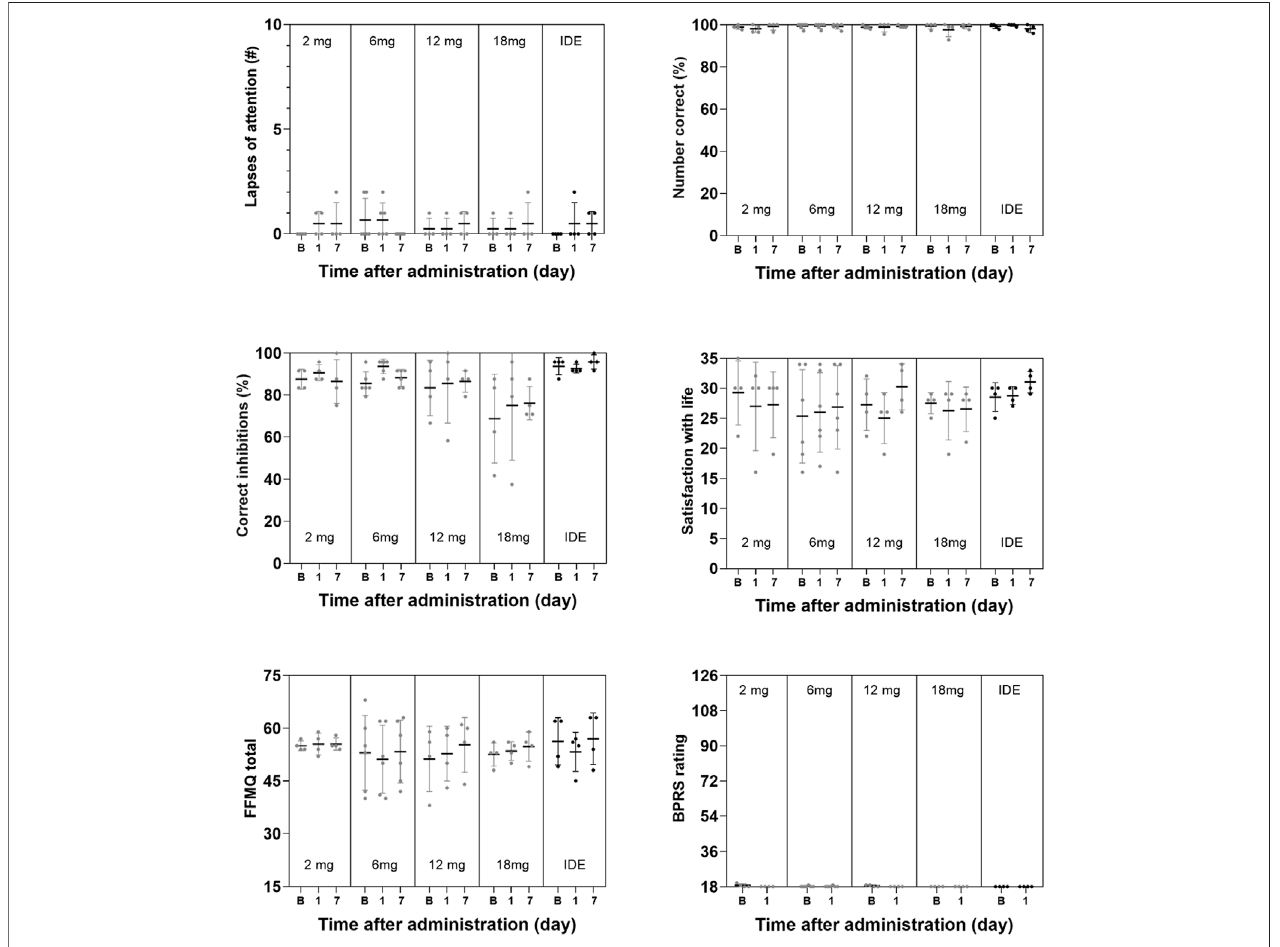
FIGURE 4 | Mean (SE) and individual lapses of attention in the PVT, number of correct responses in the DSST, number of correct inhibitions in the PVT, ratings of satisfaction with life, mindfulness (FFMQ) and BPRS in every dose condition.